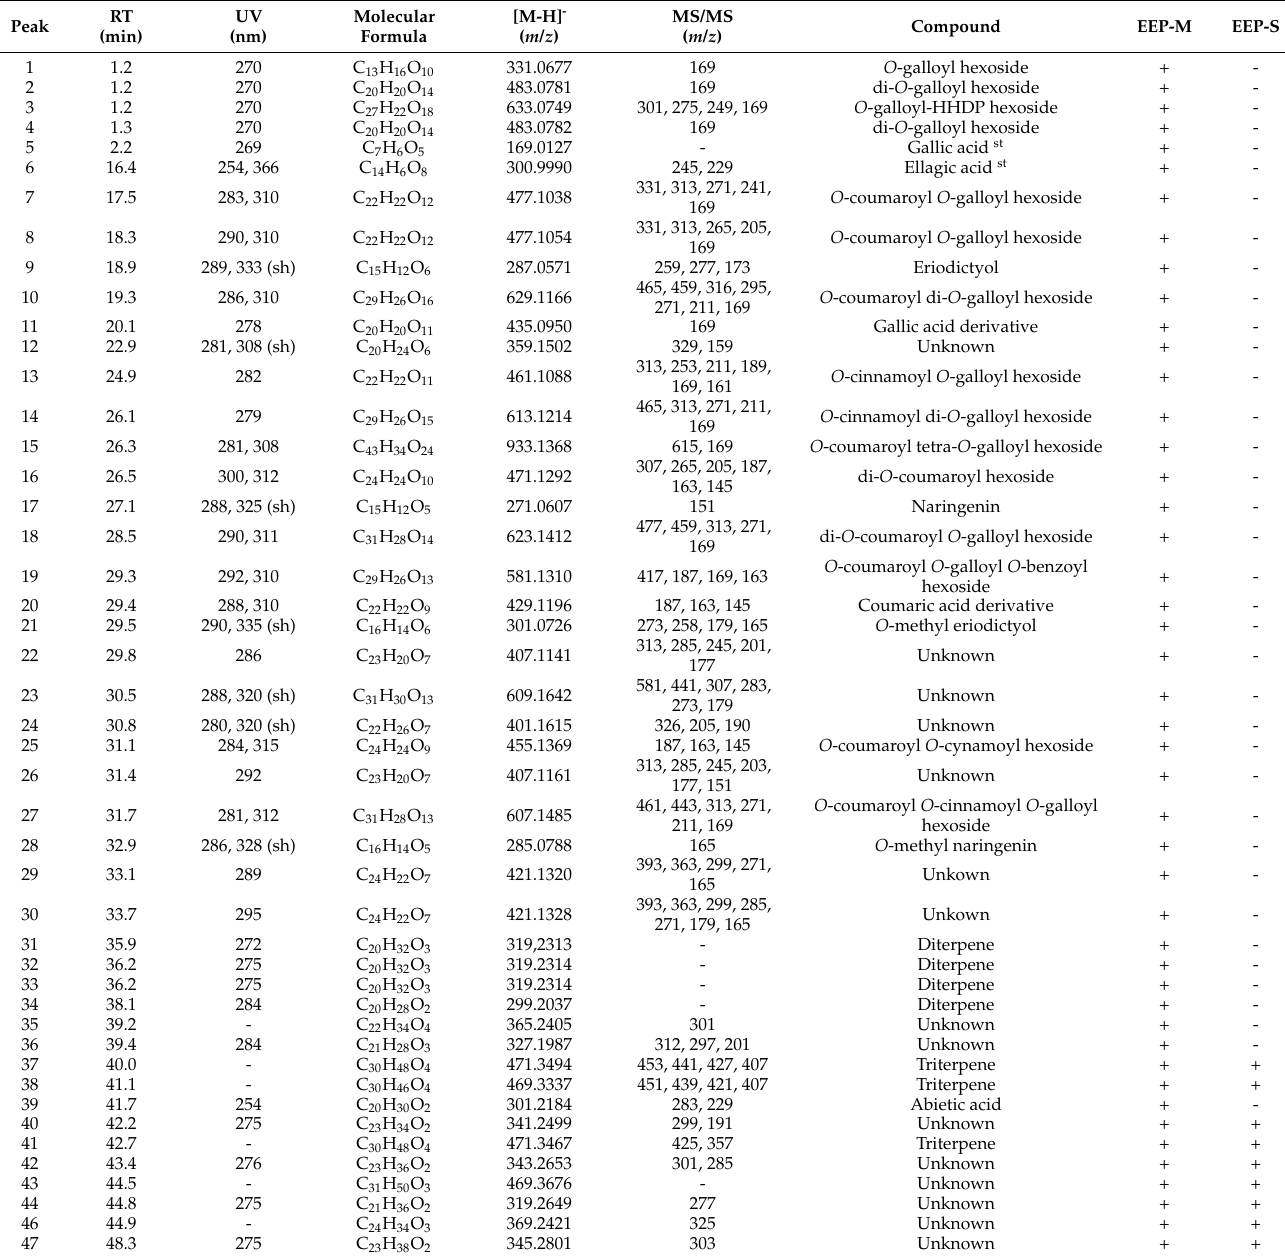
Table 2. Chemicals constituents identified from ethanolic extracts of Melipona quadrifasciata anthidiodes (EEP-M) and Scaptotrigona depilis (EEP-S) propolis by